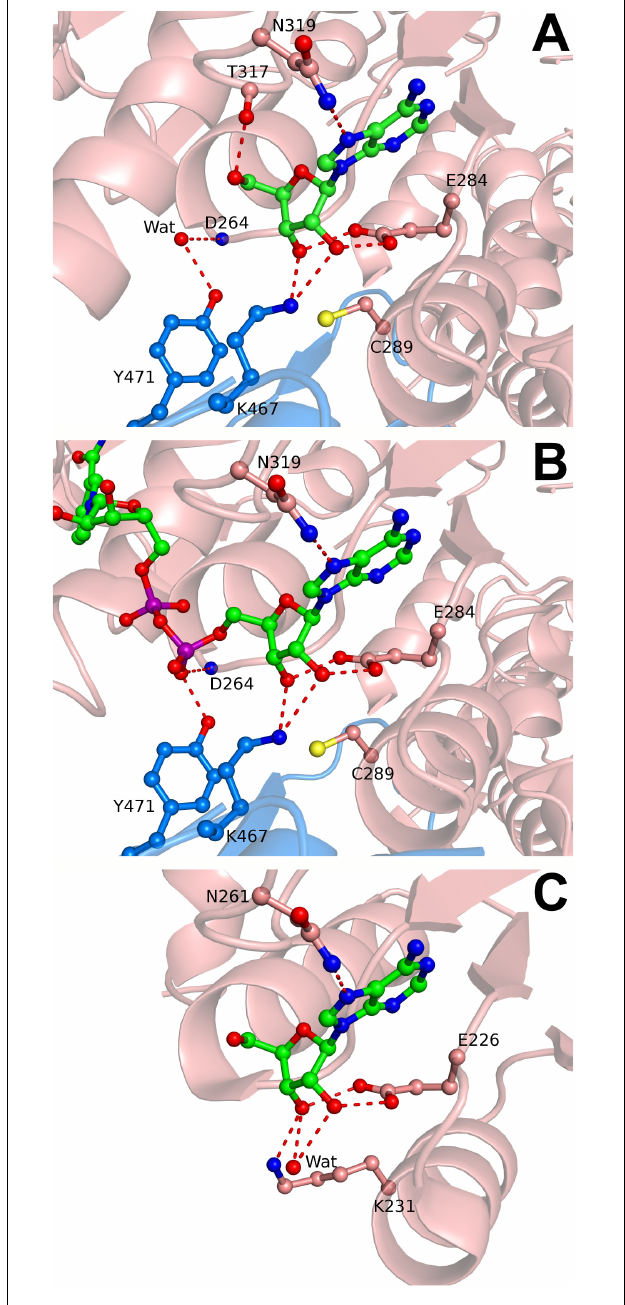
FIGURE 5 | Adenosine and NAD + binding in the cofactor site of SAHase crystal structures. (A) Ado2 (ball-and-stick) bound in the cofactor binding site of subunit A (salmon) of BeSAHase from the present study, shown in mF o -DF c difference OMIT electron density map contoured at 3 σ . Hydrogen bonds are represented by dashed lines. A water molecule that mimics a P-O − oxygen atom of NAD + is shown as a red sphere and denoted as Wat. (B) NAD + molecule (ball-and-stick) bound in subunit A of BeSAHase PDB model 5m66 (Manszewski et al., 2017). Colors/hydrogen bonds as in A . (C) Ado2 (ball-and-stick) bound in the cofactor binding site of TmSAHase (PDB entry 5tow; Brzezinski et al., 2017). Lys231, equivalent of Cys289 in the BeSAHase structure, is shown in ball-and-stick representation. Water molecule/colors/hydrogen bonds as in A